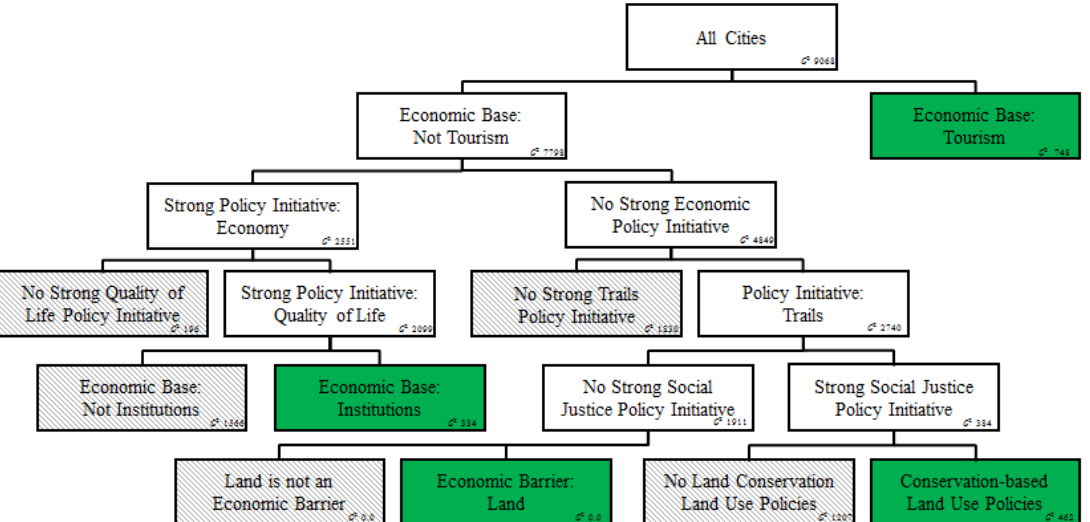
Figure 4. Decision Tree analysis results. Overall r 2 = 0.3; AICc = 1,831.42; Number of splits =